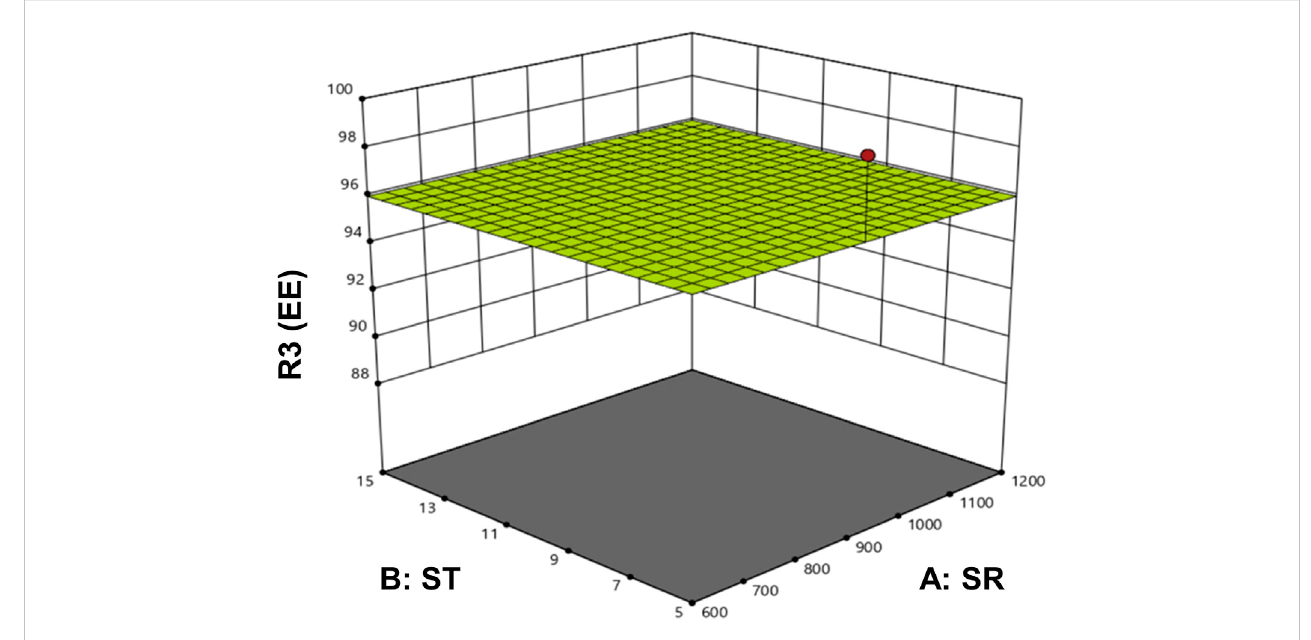
3D Model surface graph for entrapment ef fi ciency (EE).